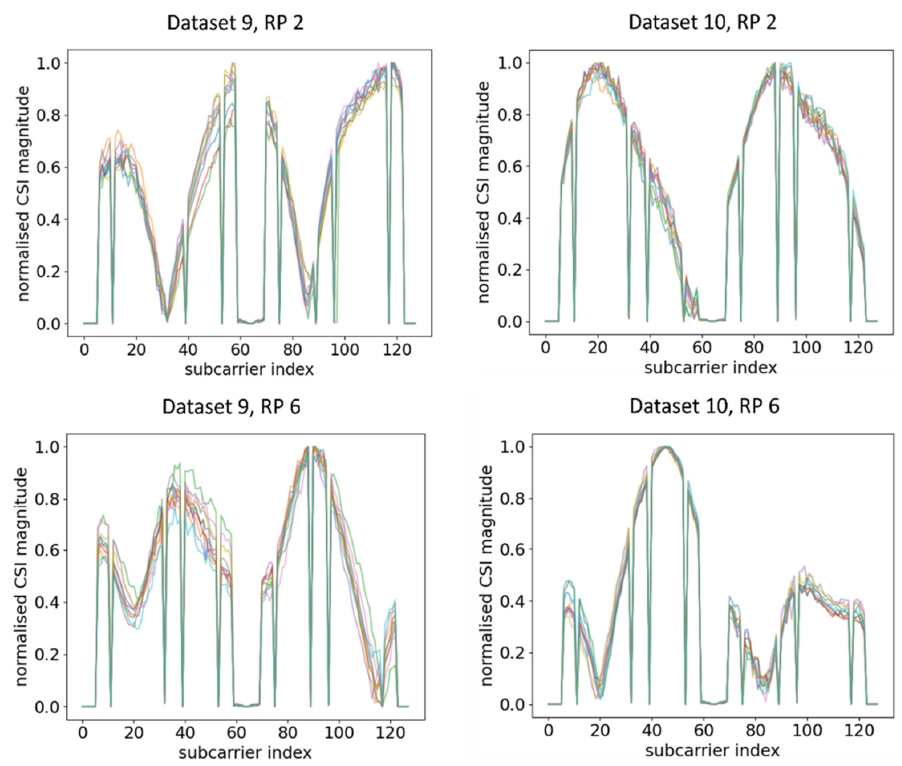
Figure 11. Plots of CSI amplitude in different orientations of RPi3B+ in the same time period at different RPs using AP 2.